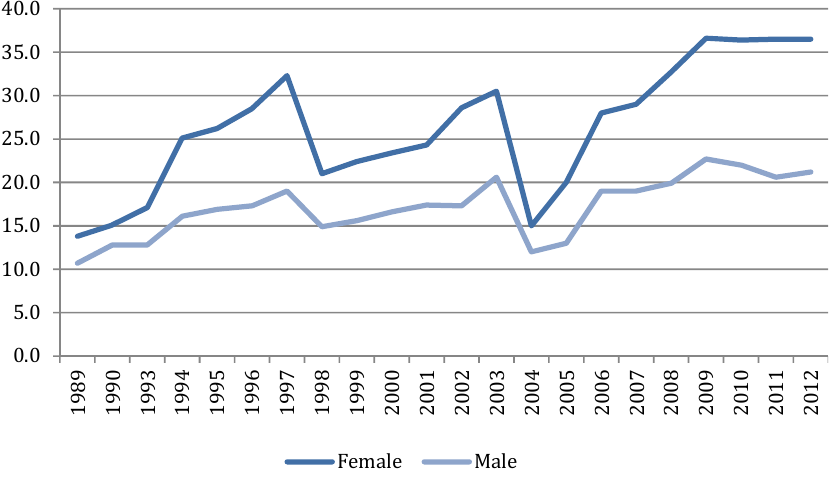
Figure 2: Proportion (%) of violent offences by sex, 1989 ‐ 2012, NSW Children’s Court Source: NSW Bureau of Crime Statistics and Research (1989‐2012) Note: Violent offences are defined as acts intended to cause injury, finalised court appearances most serious